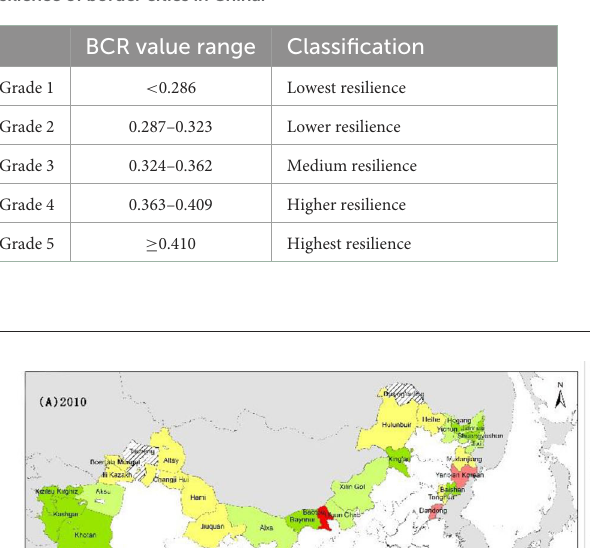
TABLE 3 Classification standard of comprehensive measure of resilience of border cities in China.